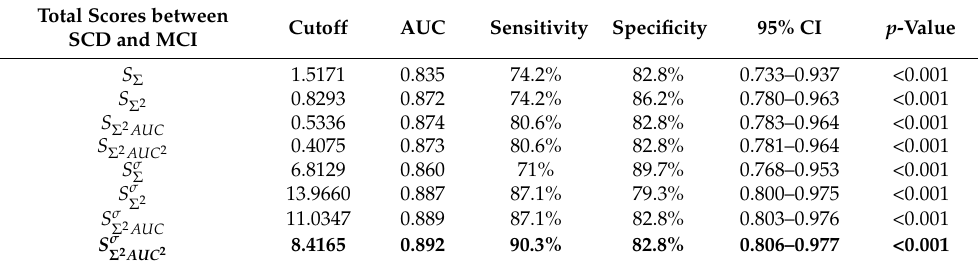
Table 8. Diagnostic score classification between SCD and MCI.